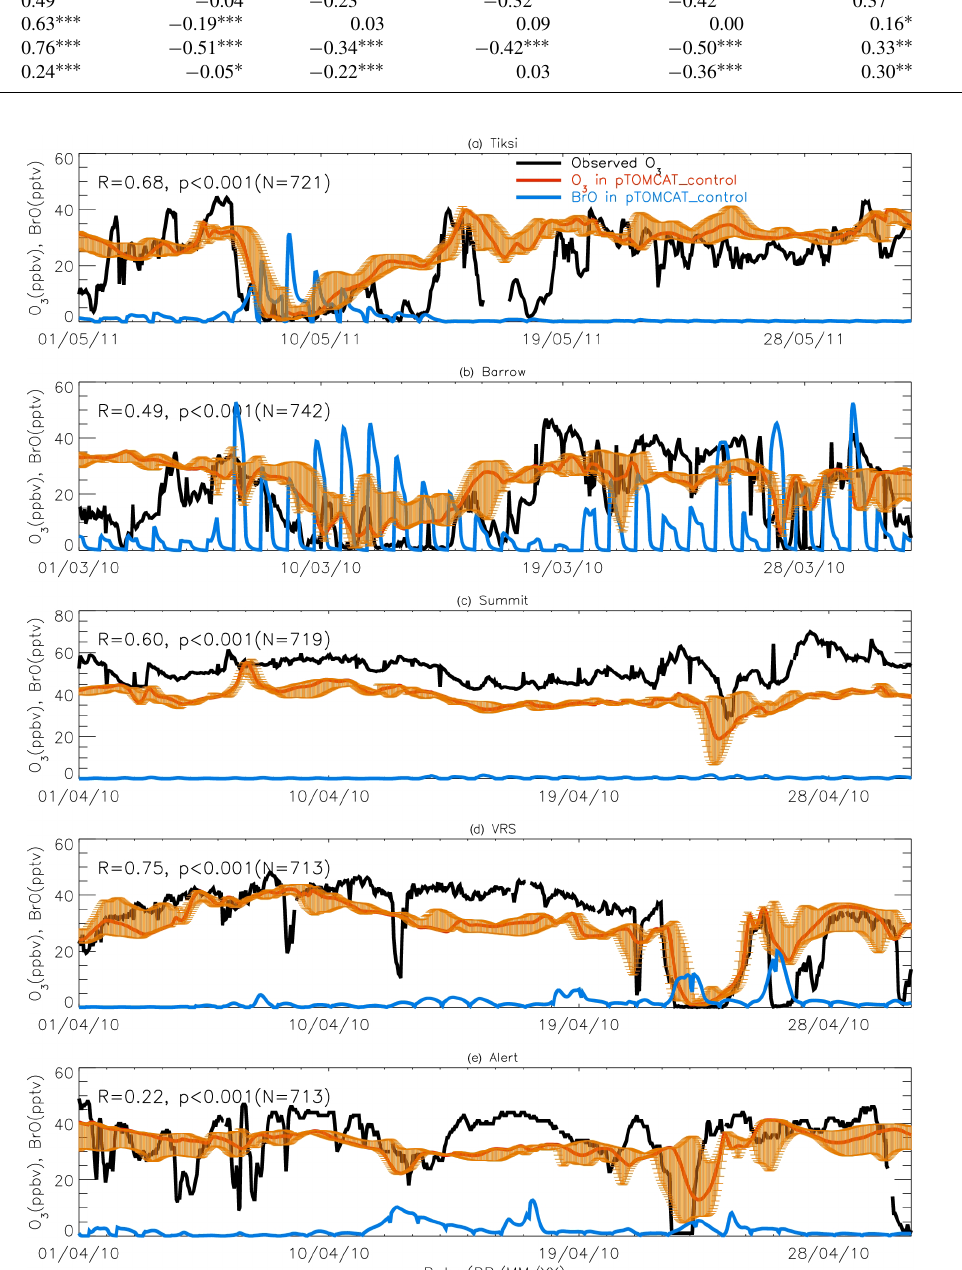
Figure 7. A 1-month-long time series of surface ozone and BrO at (a) Tiksi (May 2011), (b) Barrow (March 2010), (c) Summit (April 2010), (d) Villum (April 2010), and (e) Alert (April 2010). Observed ozone is shown in black, with pTOMCAT_control ozone shown in bold red, representing the value of the nearest central grid box to the observation site. The bold blue line is central grid box BrO. Note that maximum and minimum ozone, which are shown in orange bars, are taken from the five adjacent grid boxes next to the central grid box to highlight the possible range of the tracer